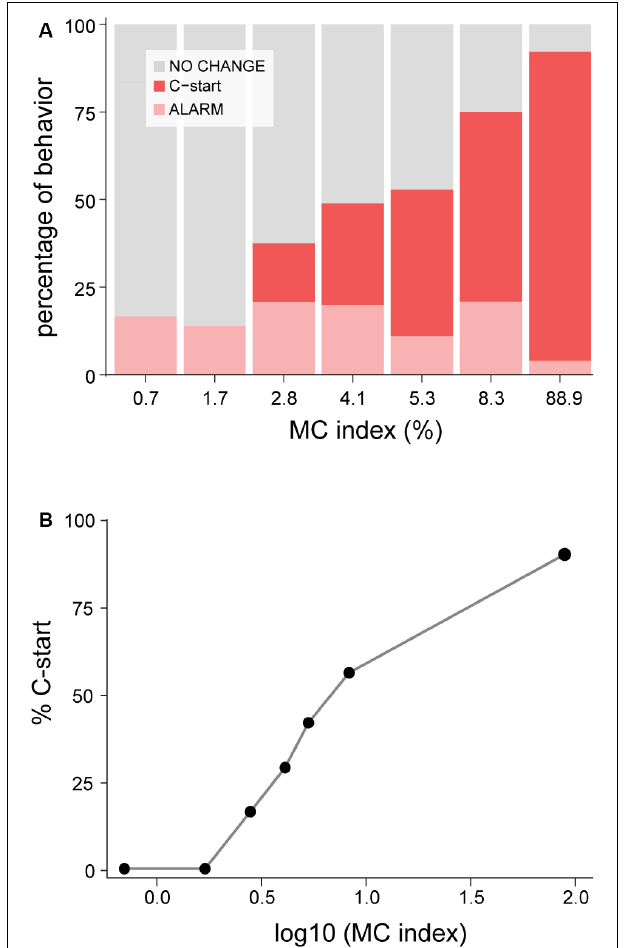
FIGURE 3 | Increasing contrast shifts fish response to C-start behavior. (A) Stacked bars indicate the relative proportion of C-starts (red), alarm responses (pink), or no change (gray) in motor behavior. Alarm behaviors are grouped but include decelerations, accelerations, and fin abductions, whose proportions did not change across stimuli. Higher contrast stimuli produced a higher proportion of C-starts (binomial generalized linear model (GLM), effect of contrast on C-start probability, p < 0.001) but no significant change on the proportion of alarm responses (binomial GLM, effect of contrast on alarm responses, p = 0.03). (B) Percentage (%) of C-start probability vs. MC represented in a logarithmic scale. ( Figure 4B , median, IC 89 : 25 ms; IC 4.1 : 21 ms, IC 2.8 : 25 ms, linear model n.s.) or angular bend performed ( Figure 4C , median, IC 89 : 71 ◦ ; IC 4.1 : 70 ◦ , IC 2.8 : 70 ◦ , linear model